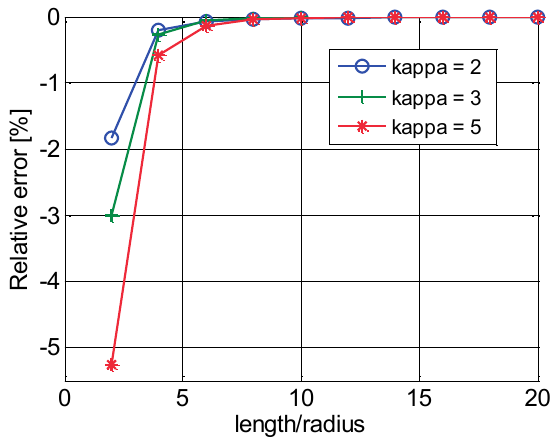
Figure 12: Relative error of the mean distances formula (62).